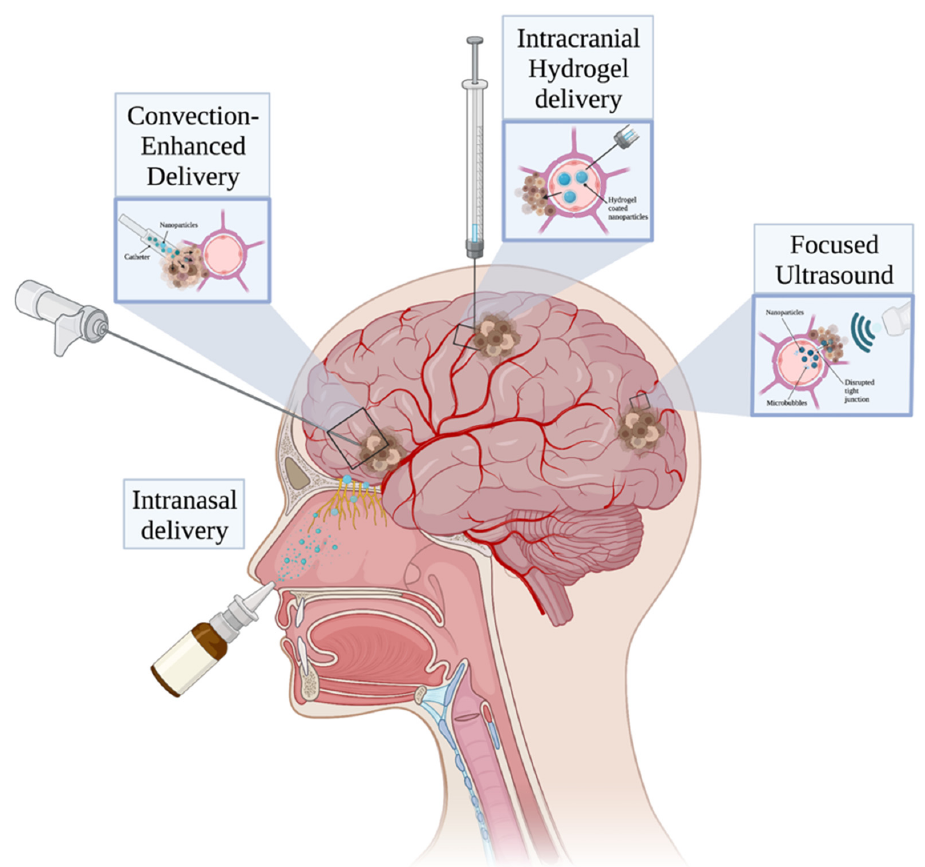
Figure 3. Methods of nanoparticle administration.